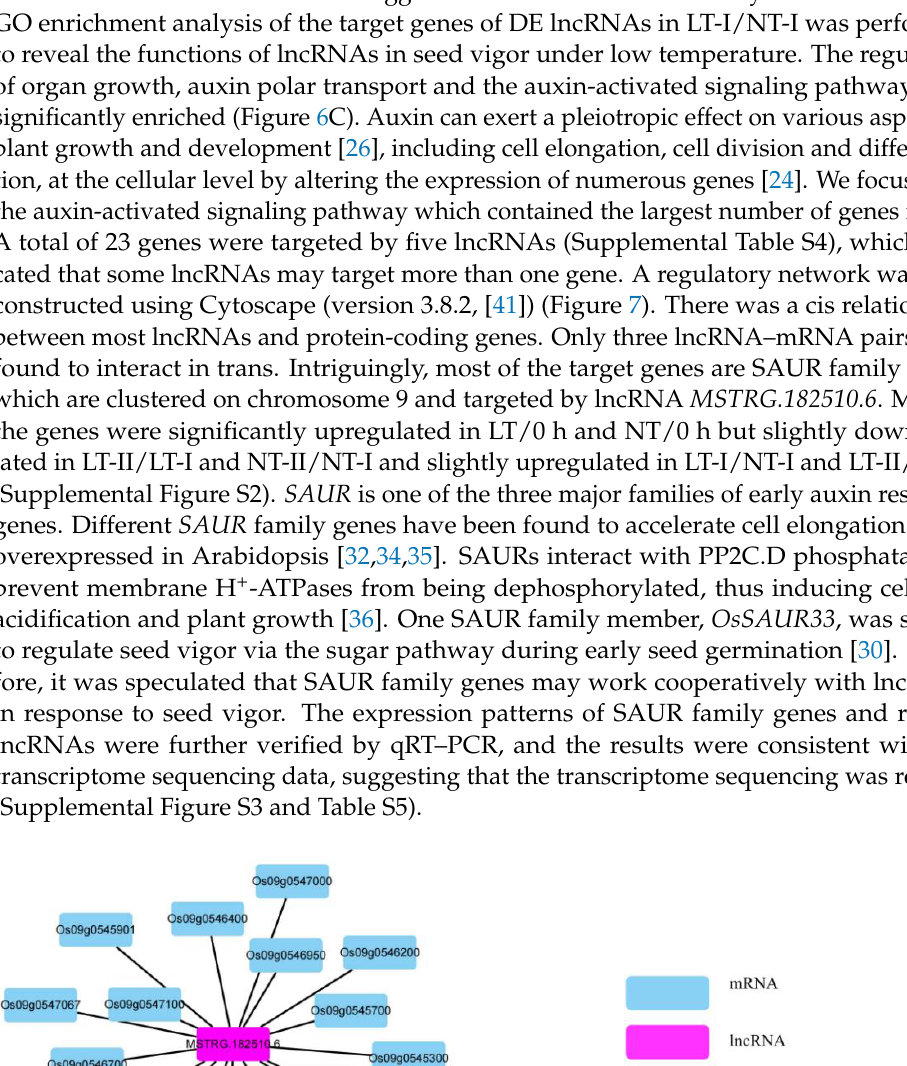
Figure 6. GO enrichment analysis of genes targeted by the DE lncRNAs. ( A ) Biological process terms enriched among target genes of LT-I/0 h DE lncRNAs. ( B ) Biological process terms enriched among target genes of LT-II/LT-I DE lncRNAs. ( C ) Biological process terms enriched among target genes of LT-I/NT-I DE lncRNAs. ( D ) Biological process terms enriched among target genes of LT-II/NT-II DE lncRNAs.